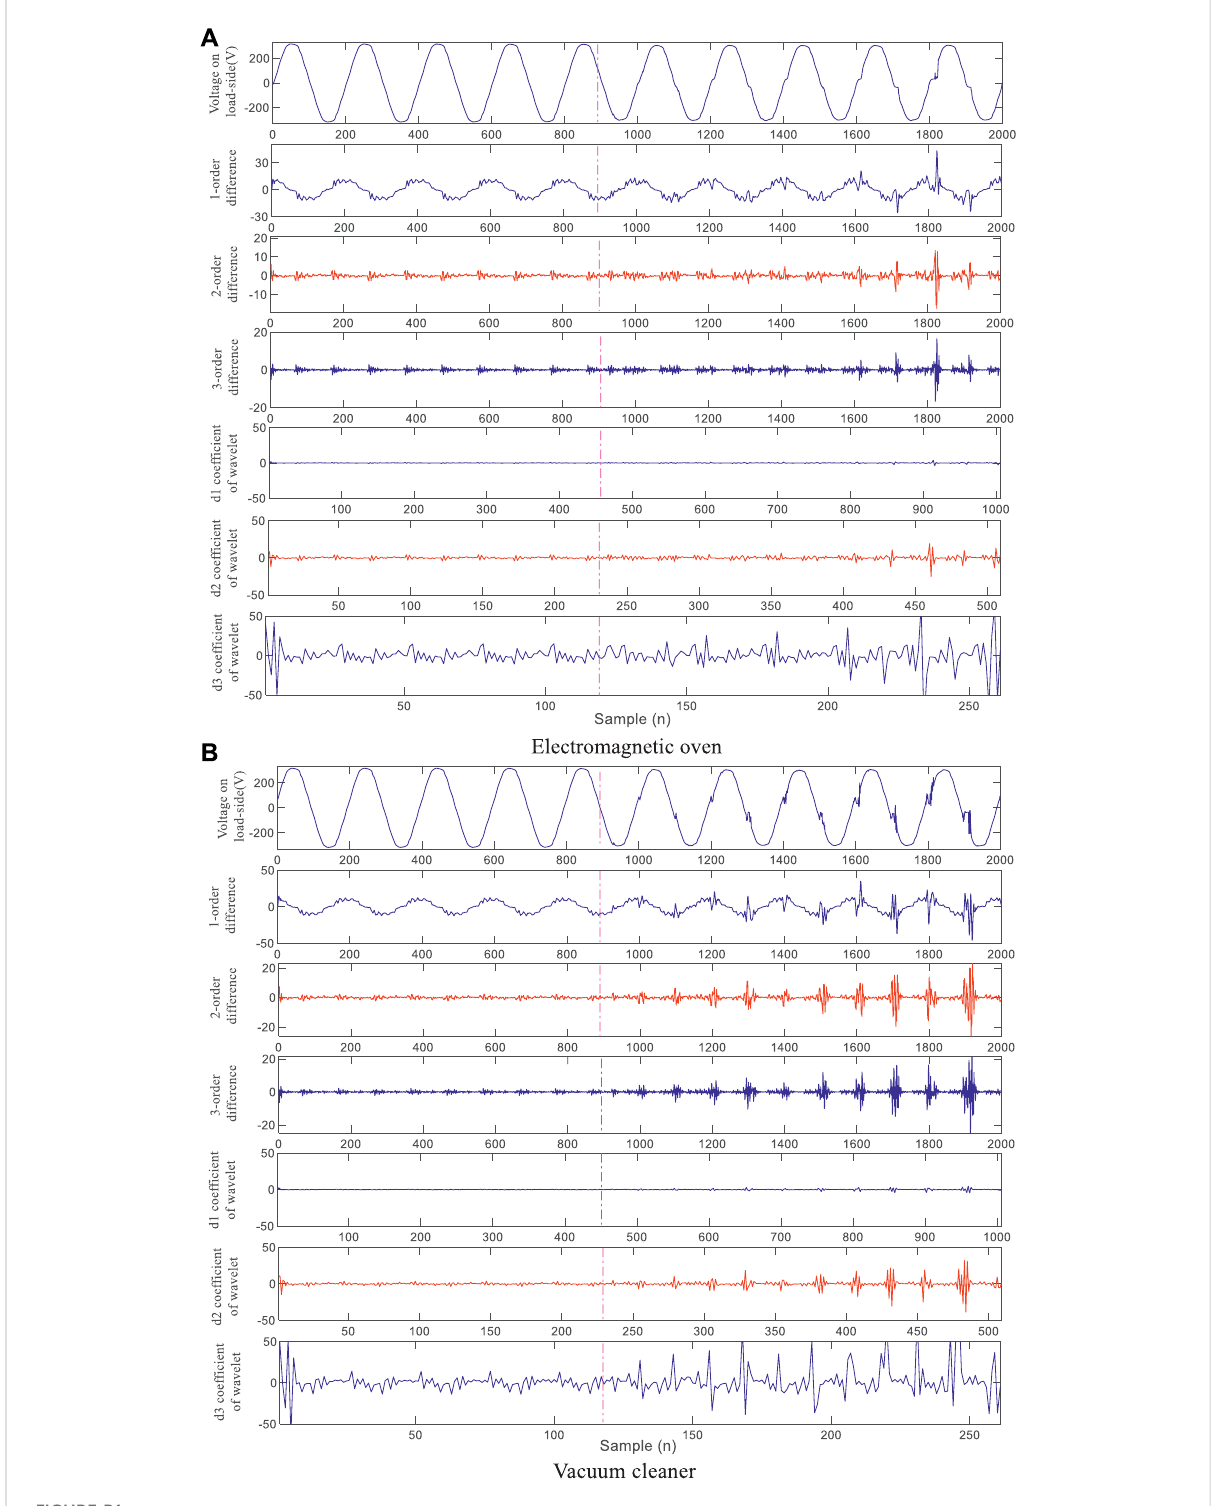
FIGURE B1 Comparison of different orders differences and wavelet coef fi cients (A) Electromagnetic oven (B) Vacuum